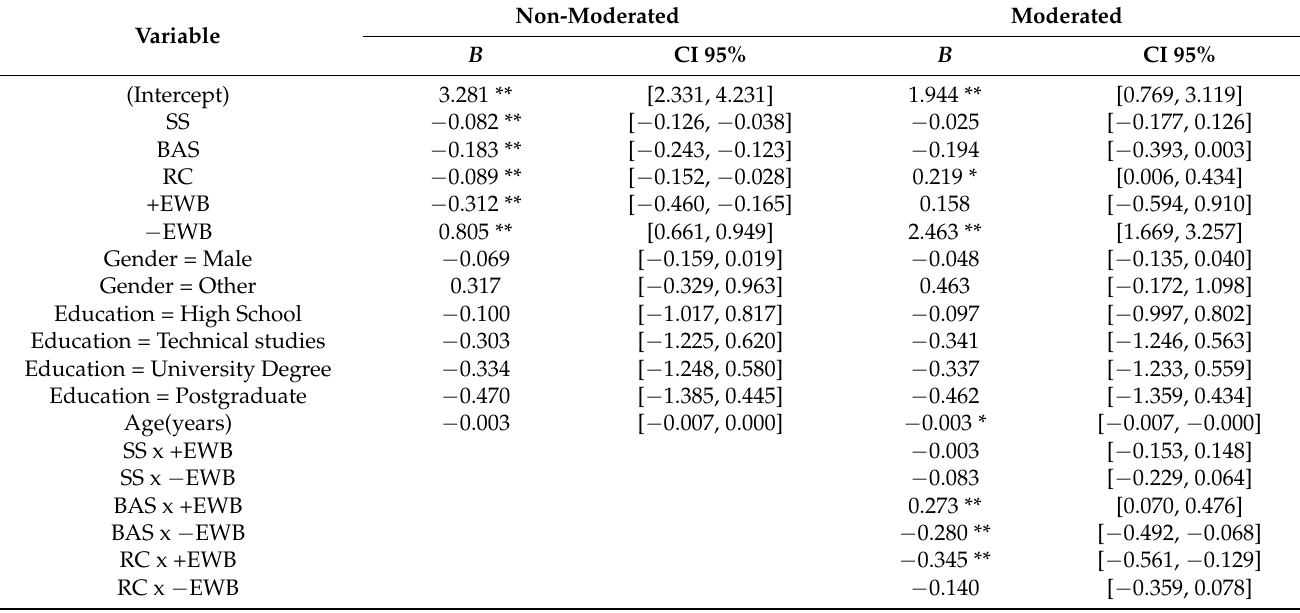
Table 2. Non-moderated and Moderated regression analysis summary for the interaction between SS (Social Support), BAS (Beliefs about stress), and RC (Resilient Coping); and +EWB (Positive